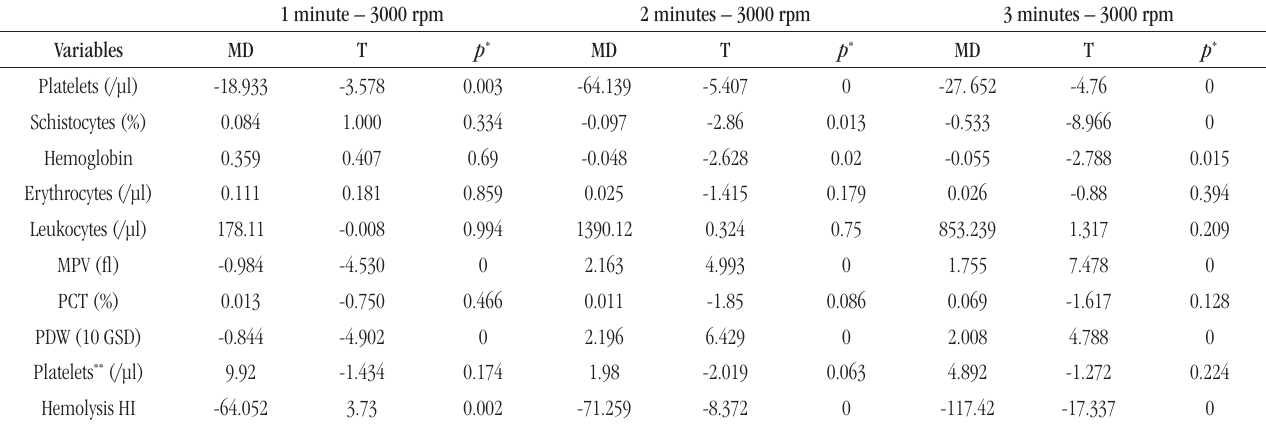
taBLE 2 − Statistical evaluation of vortex efficiency in the dissolution of platelet aggregates and alteration of constants and hematimetric indices